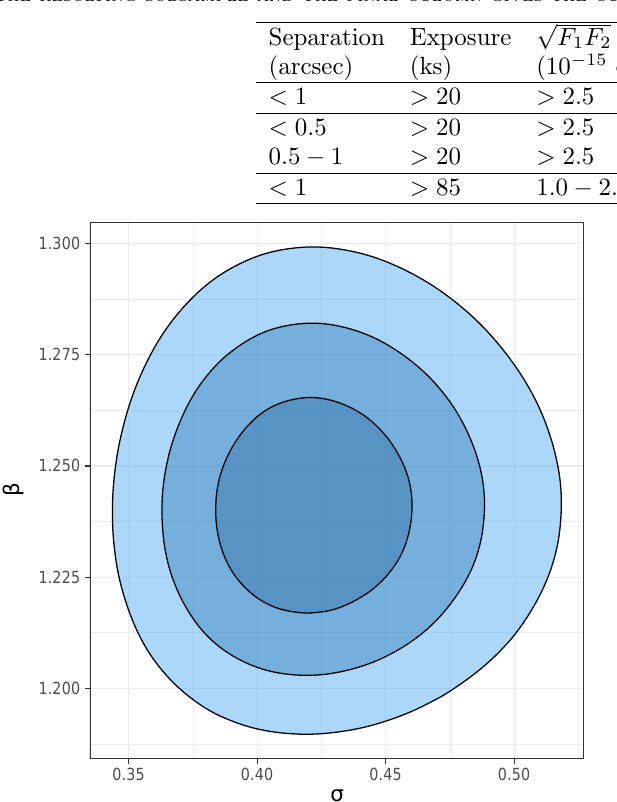
Fig. 4.— Constraints on AGN variability σ and log( N ) − log( S ) slope β from the primary sample. The shaded regions enclose the 1 σ , 2 σ and 3 σ confidence intervals on the